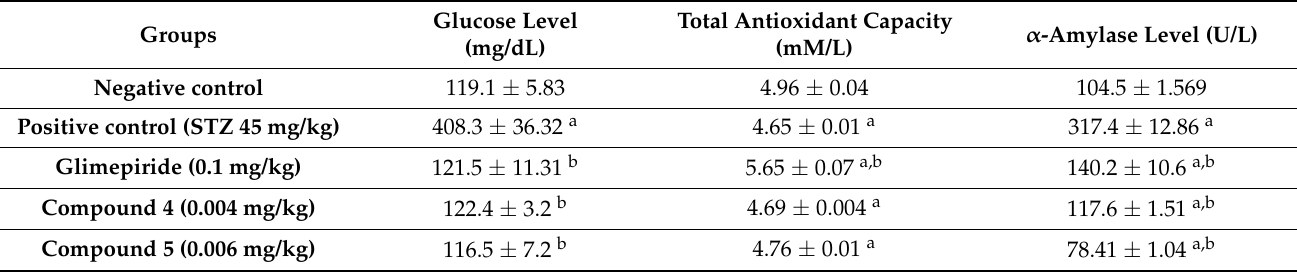
Table 1. Effects of compounds 4 and 5 on glucose level, total antioxidant capacity and alpha amylase level in serum of STZ diabetic